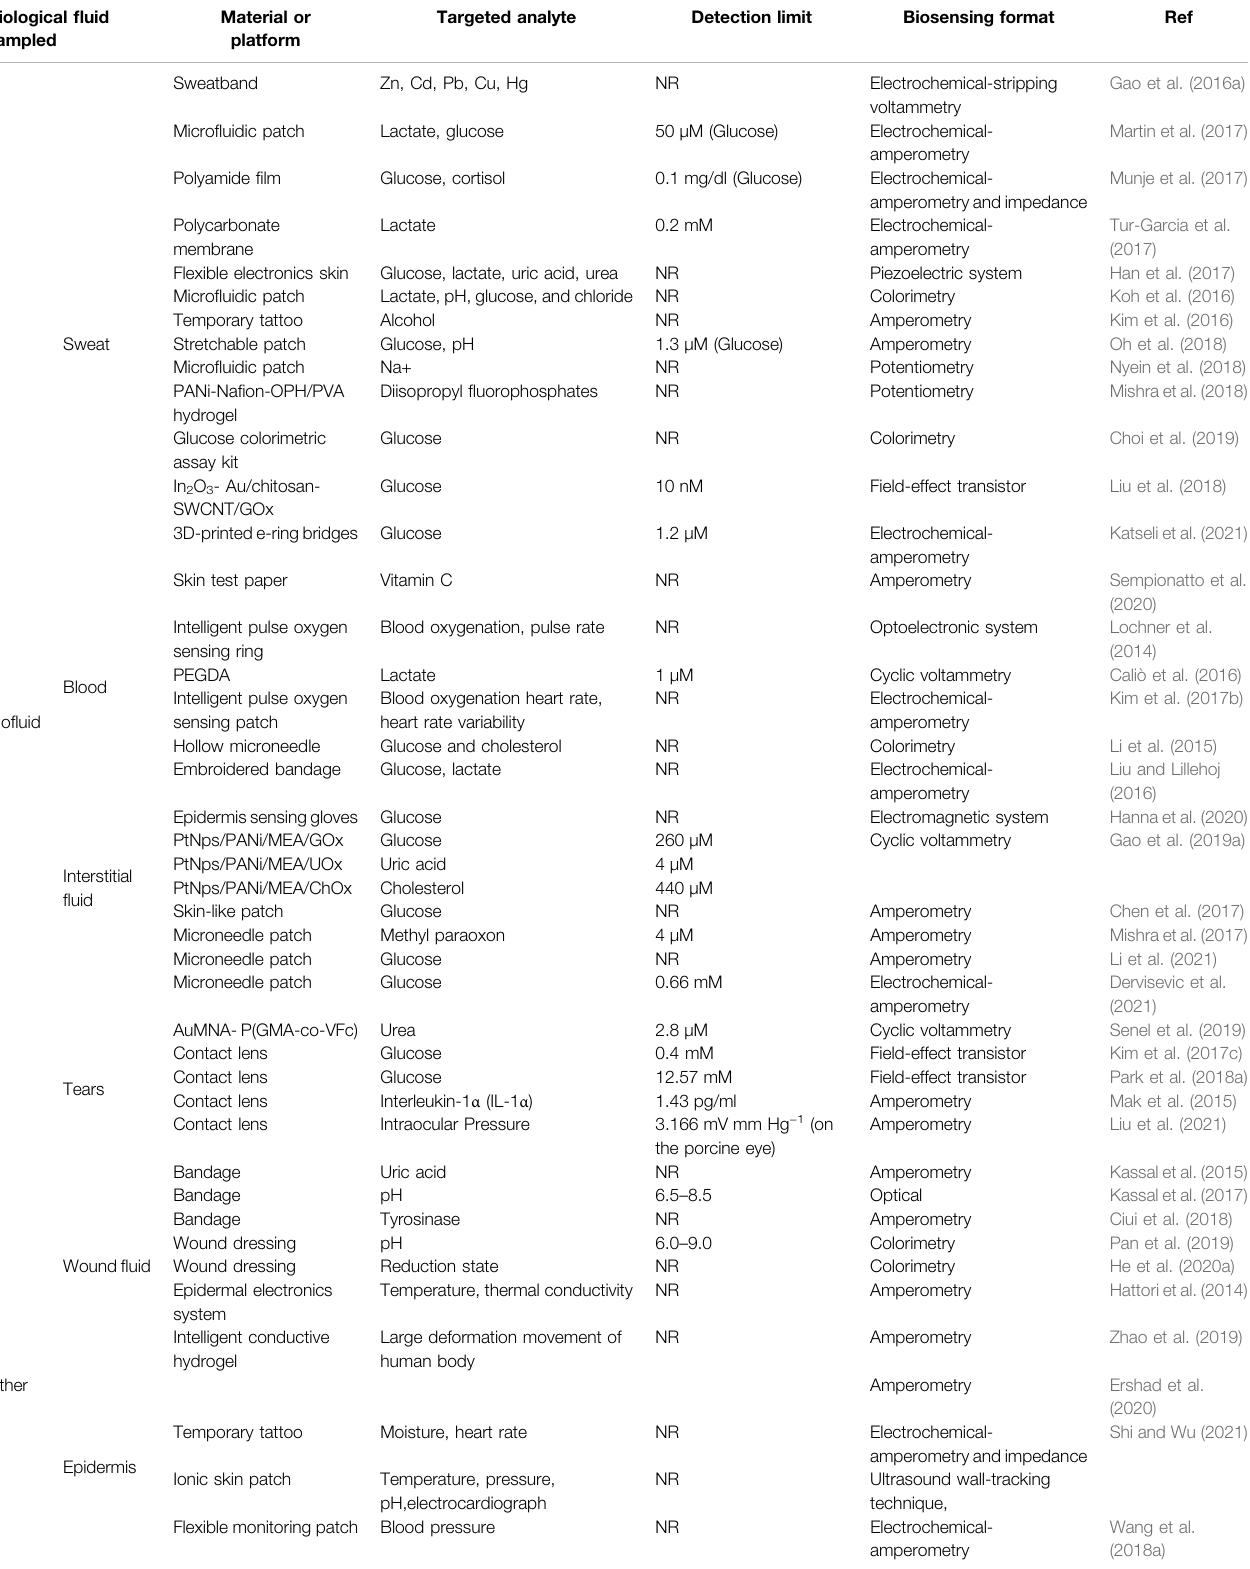
TABLE 2 | Representative new intelligent wearable sensor platforms based on bio fl uids. Biological fl uid